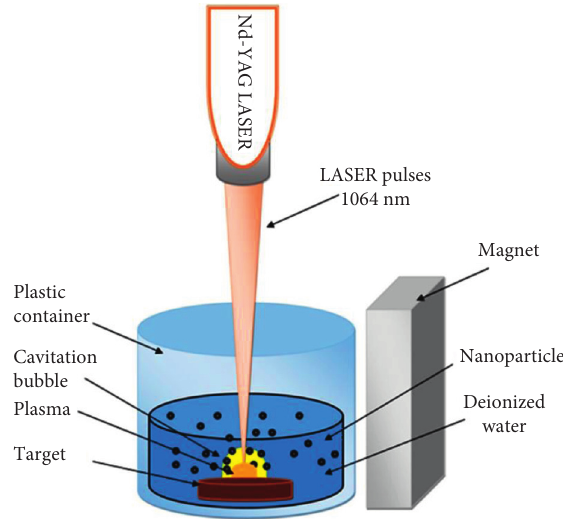
Figure 1: Schematic illustration of NPs production through the LASER ablation procedure in liquid